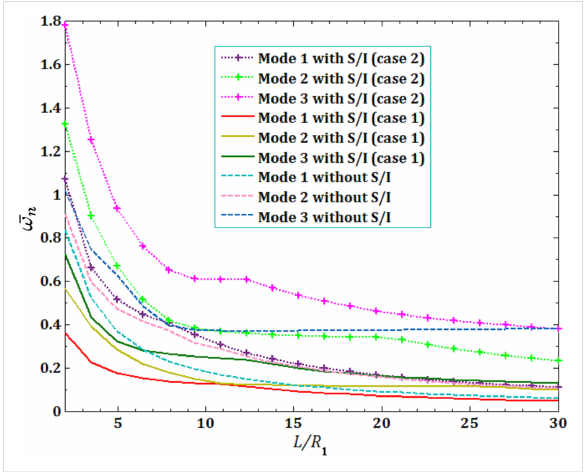
Figure 2: The surface/interface effects on DNF versus the L / R 1 ratio for three vibrational modes.